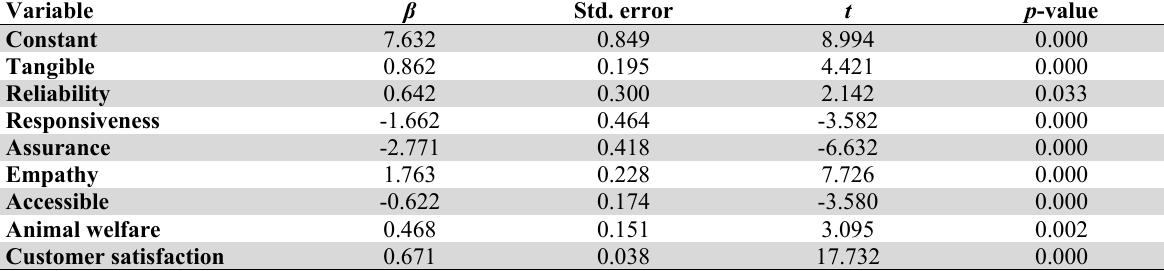
Regression Analysis Between Service Quality Dimensions, Customer Satisfaction and Customer Loyalty Variable